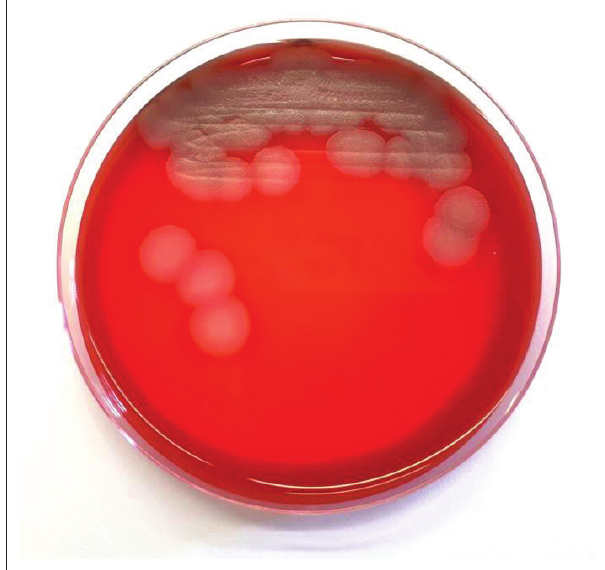
FIGURE 1: Typical morphology of Bacillus cereus on 5 % horse blood agar (Pretoria, South Africa, 19 March